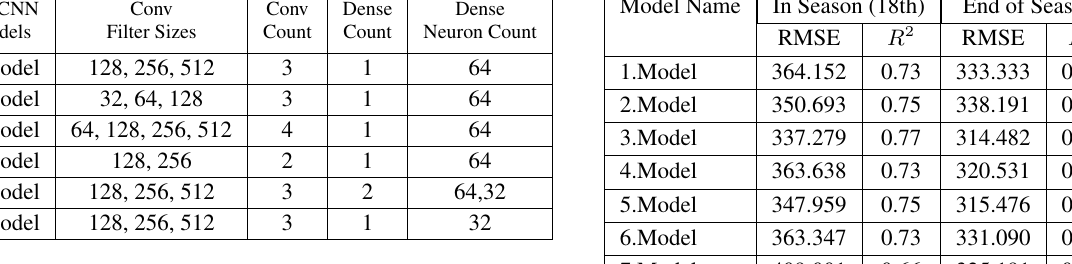
Table 4. HistCNN model configuration matrix.